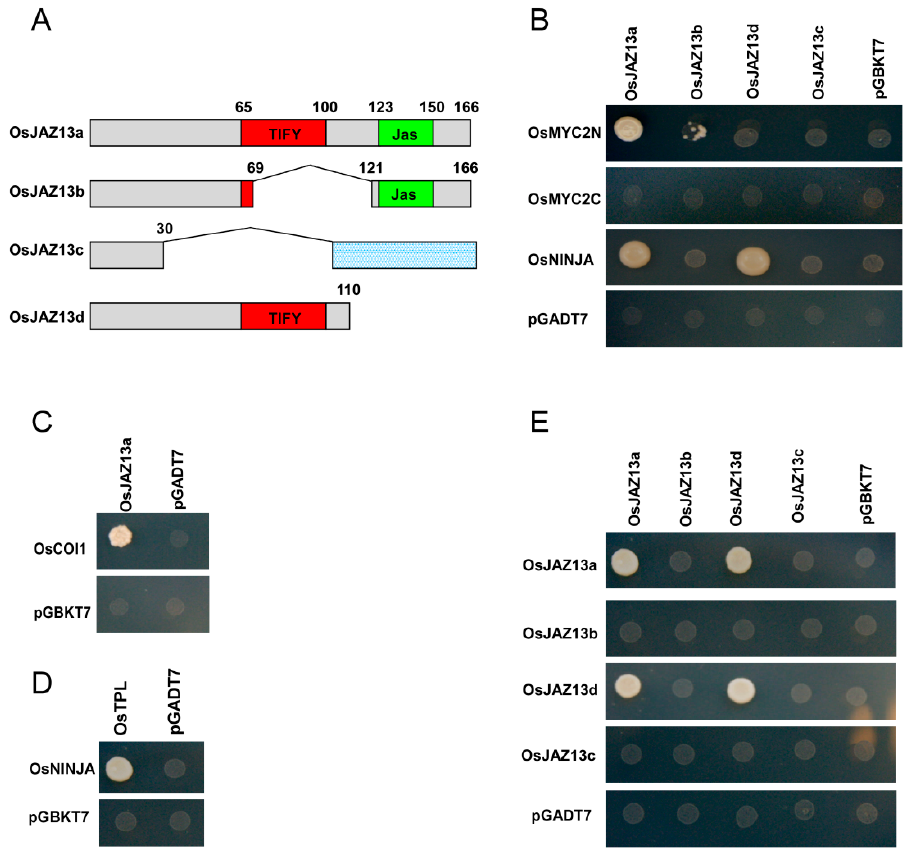
Figure 4. Y2H assay of the interactions between OsJAZ13 and the key regulators of the JA signaling pathway. ( A ) Schematic diagram of OsJAZ13 splice variants and the truncated derivative. The diagram displays the highly conserved Jas (green) and TIFY (red) domains, as well as the weakly conserved sequence (gray). The indicated combinations of plasmids were cotransformed into the yeast reporter strain Y2H gold; successfully transformed colonies were identified on appropriate selective minimal agar. ( B ) Interaction of OsJAZ13a, OsJAZ13b, OsJAZ13c, and OsJAZ13d with OsMYC2 derivatives or OsNINJA in the Y2H system. ( C ) Coronatine-dependent interaction of OsJAZ13a with OsCOI1 in the Y2H system. ( D ) Interaction between OsNINJA and OsTPL in the Y2H system. ( E ) Y2H analysis of the dimerization of OsJAZ13 splice variants (OsJAZ13a, OsJAZ13b, OsJAZ13c) and the truncated derivative OsJAZ13d. The empty bait (pGBKT7) and prey (pGADT7) vectors were used as negative controls. This experiment was performed for at least three independent biological repeats.